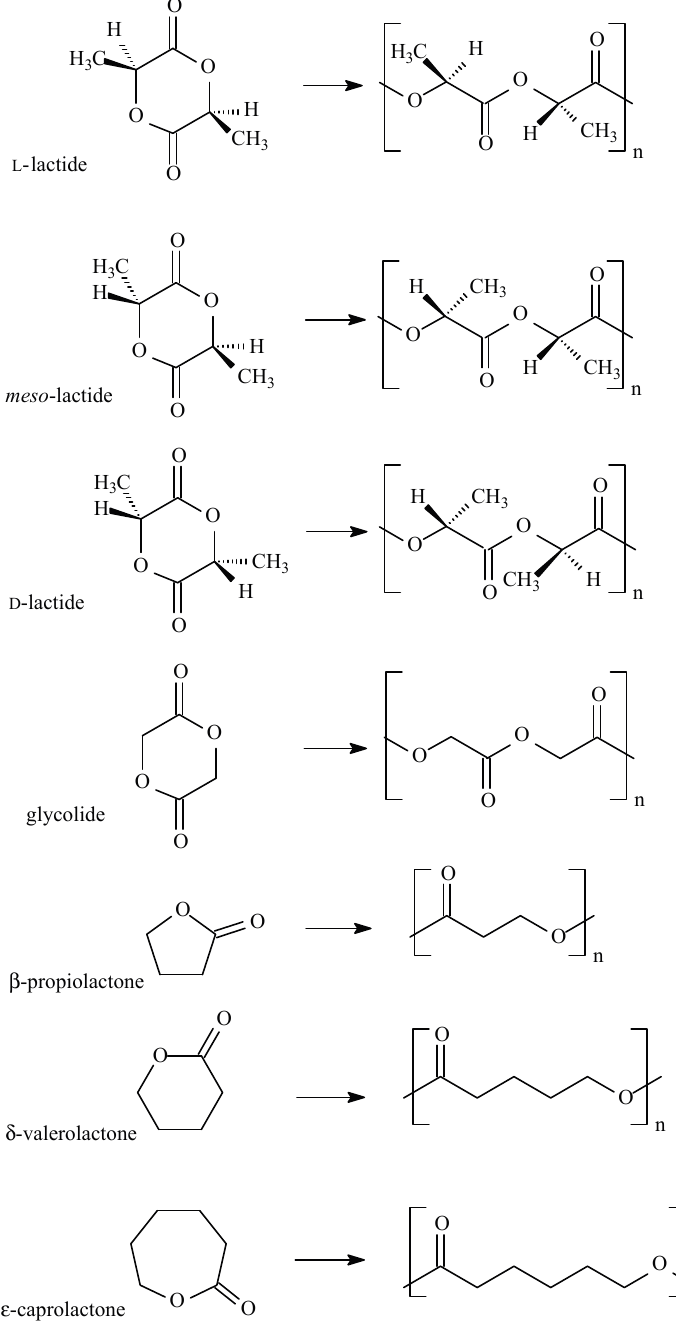
Scheme 1. The synthesis of biodegradable polyesters used in DDS